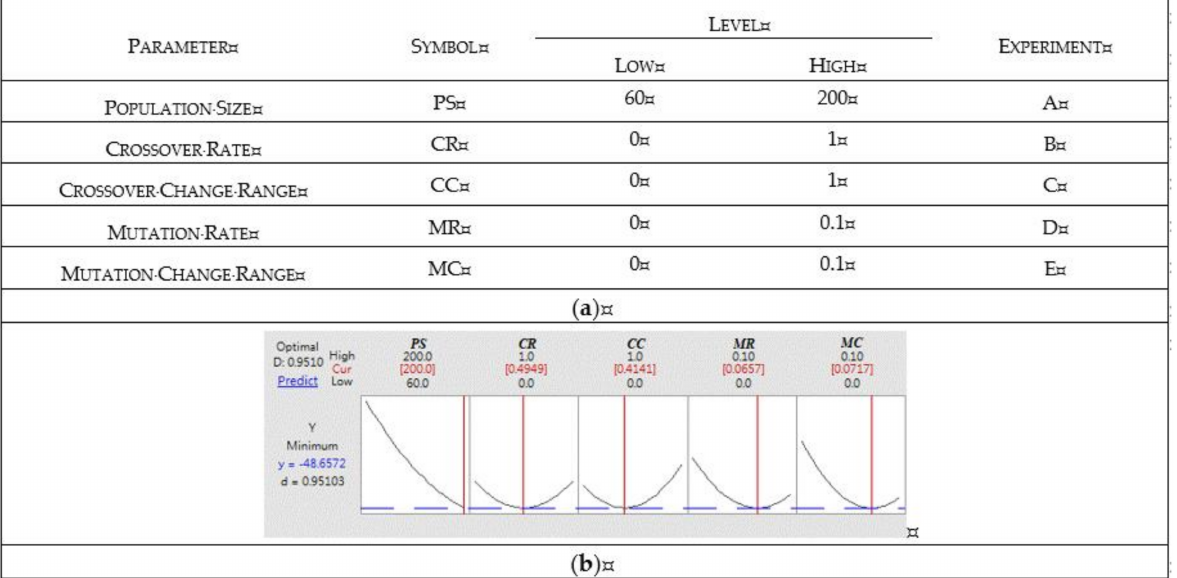
Table 2. Optimal values for the small-size test instances using an exact method. Exact Optimizer AGA Ins. N W Objective Value CPU